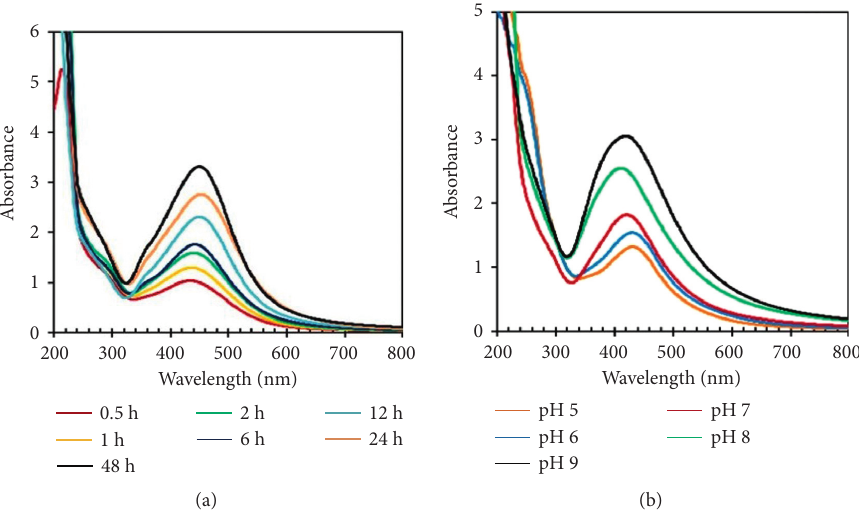
Figure 2: (a) Time-dependent absorption spectra of the reaction mixtures consisting of AgNO [59] (open access and reprinted under CC BY 4.0). (b) pH-dependent absorption spectra of the reaction mixtures of AgNO3 and Piper chaba extract after the reaction for 1h at 60 ° C [59] (open access and reprinted under CC BY